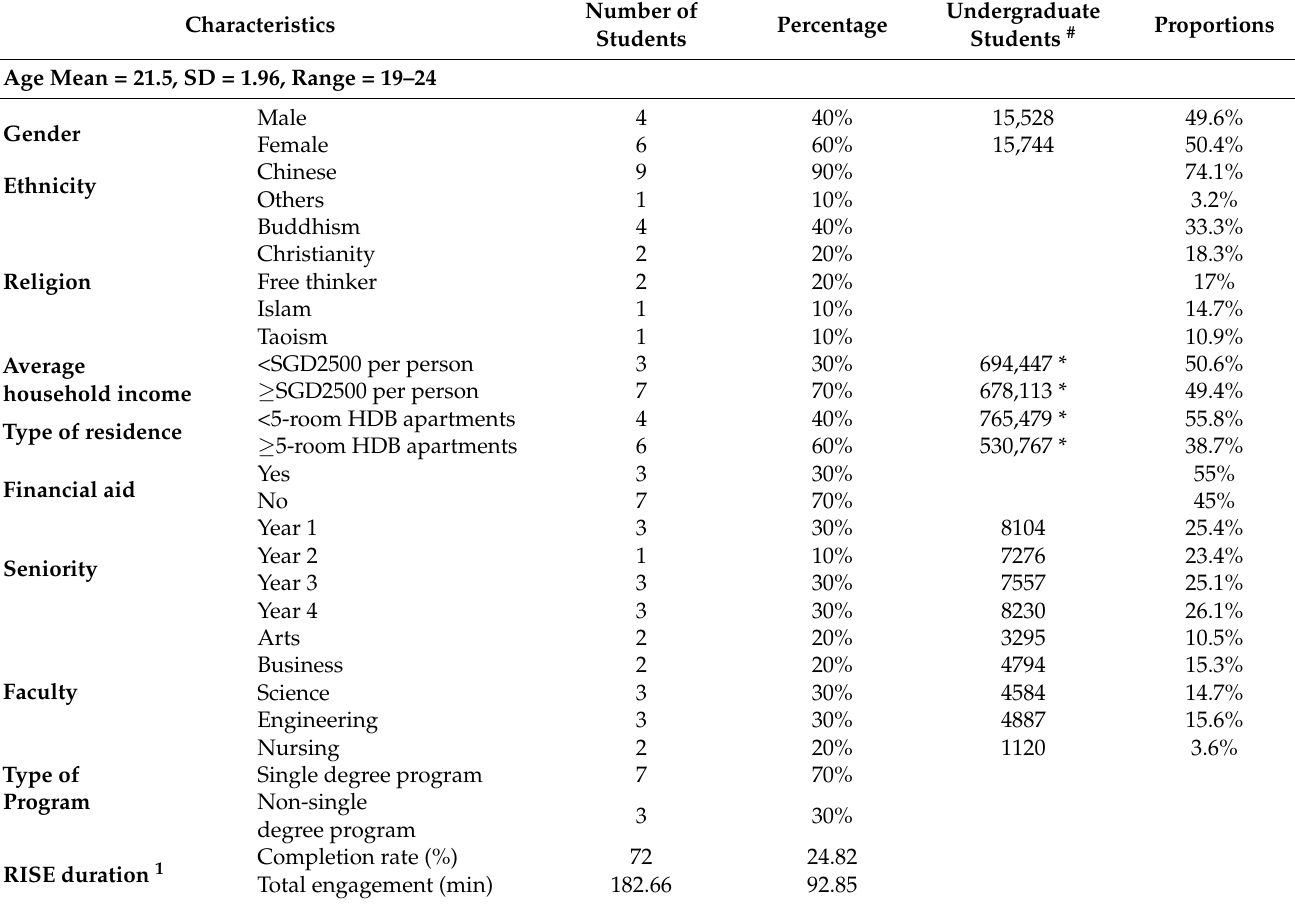
Table 2. Sociodemographic and academic characteristics of the